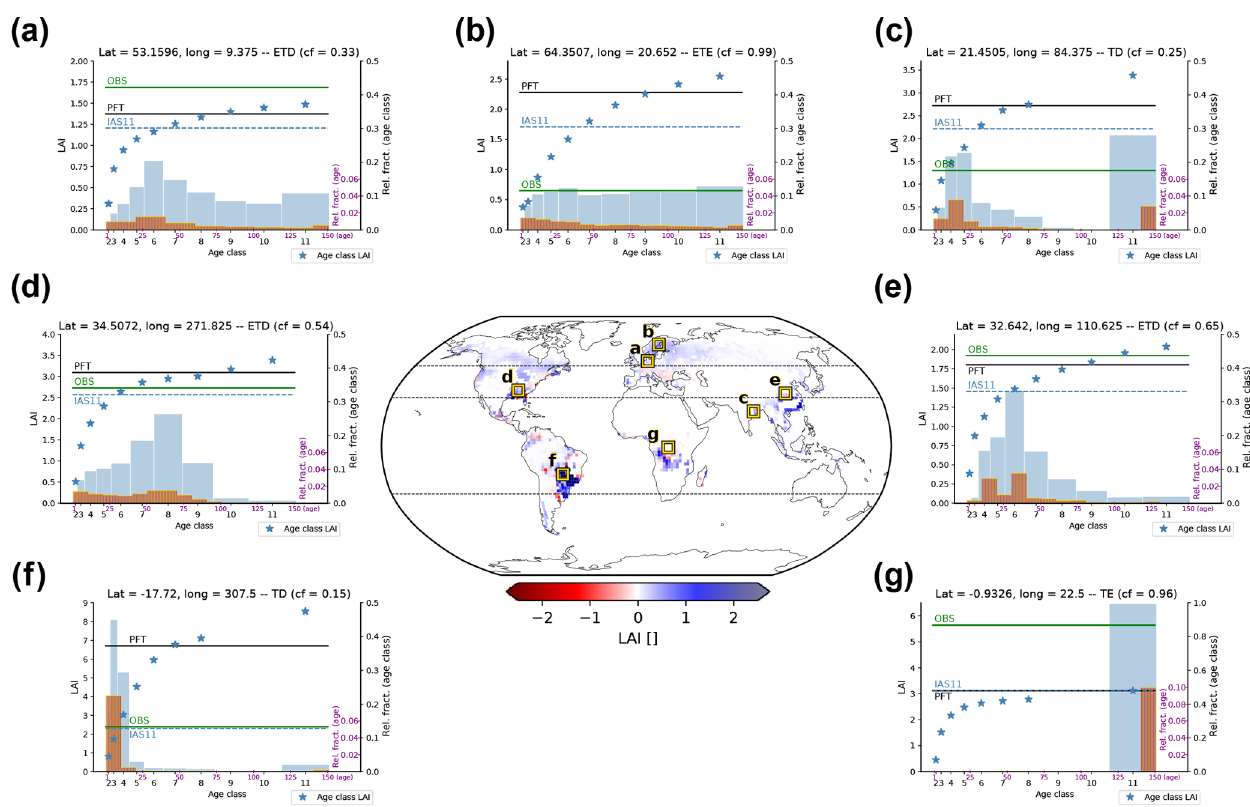
Figure 7. Example grid points comparing 2001–2010 mean spring leaf area index (MAM LAI) from the simulations without (PFT) and with age classes (IAS11) to observation-based data (OBS). The map in the centre shows the difference of differences between the observation- based data and the simulations (abs(OBS-PFT)-abs(OBS-IAS11)); i.e. it shows where the results from the simulation with age classes (IAS11) deviate less (blue) or more (red) from the observation-based data than the PFT simulation results (see also Figs. S4.2–S4.4, column 4). Dashed lines in the map mark the three selected regions (see Table 2). The plots (a) – (g) show the LAI of selected PFTs (ETD: extratropical deciduous; ETE: extratropical evergreen; TD: tropical deciduous; TE: tropical evergreen) as well as their according area fractions per age class and per year at the labelled grid points. Centre latitude, longitude, and grid-cell cover fraction (cf) of the depicted PFT are indicated. The x axis reflects the age from 0–151 (purple) with the age classes (black) indicated at the age centres. The two right y axes represent the bars: depicted are the 2010 area fractions relative to the area of the depicted PFT. Blue bars are per age class (black y axes) and depict the fraction of each age class (i.e. one bar per age class); the yellow framed purple bars depict the fraction of each age (i.e. one bar per year). The left y axis depicts the LAI. Stars mark the simulated LAI per age class and the lines the LAI of the depicted PFT – blue dashed line: IAS11 simulation; black line: PFT simulation; green line: 2010 value from the observation-based data. Note: (1) the age-class LAI is only depicted for age classes having non-zero fractional cover over the whole time span 2001–2010 (this is not the case for the age classes 9 and 10 in panels c , f , and g ); (2) age and age-class fractions of classes 2–8 in panel (g) are very small and therefore not visible above the x axis; (3) since we did not apply any harvest in the final simulation year 2010, the first year and accordingly the youngest age class are always